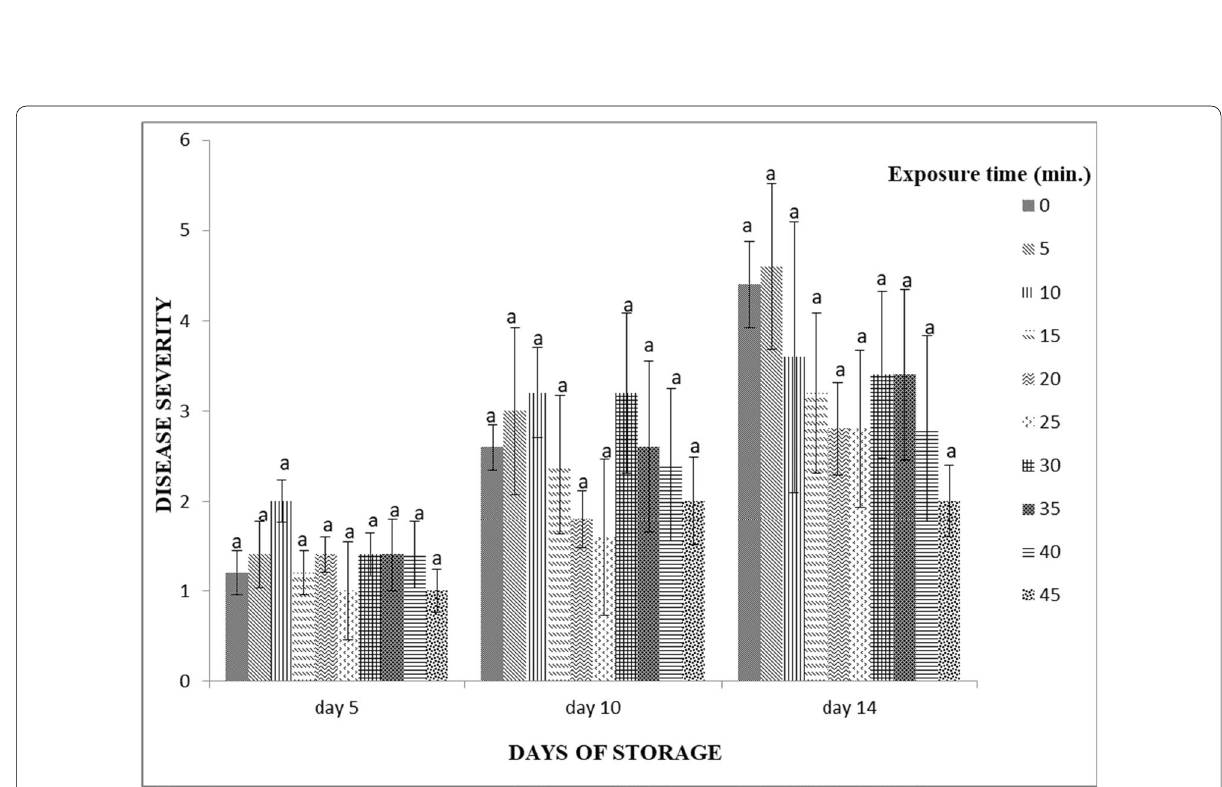
Fig. 3 Effect of exposure to gasoline fuel emission on severity of rot on tomato fruits wound inoculated with Fusarium